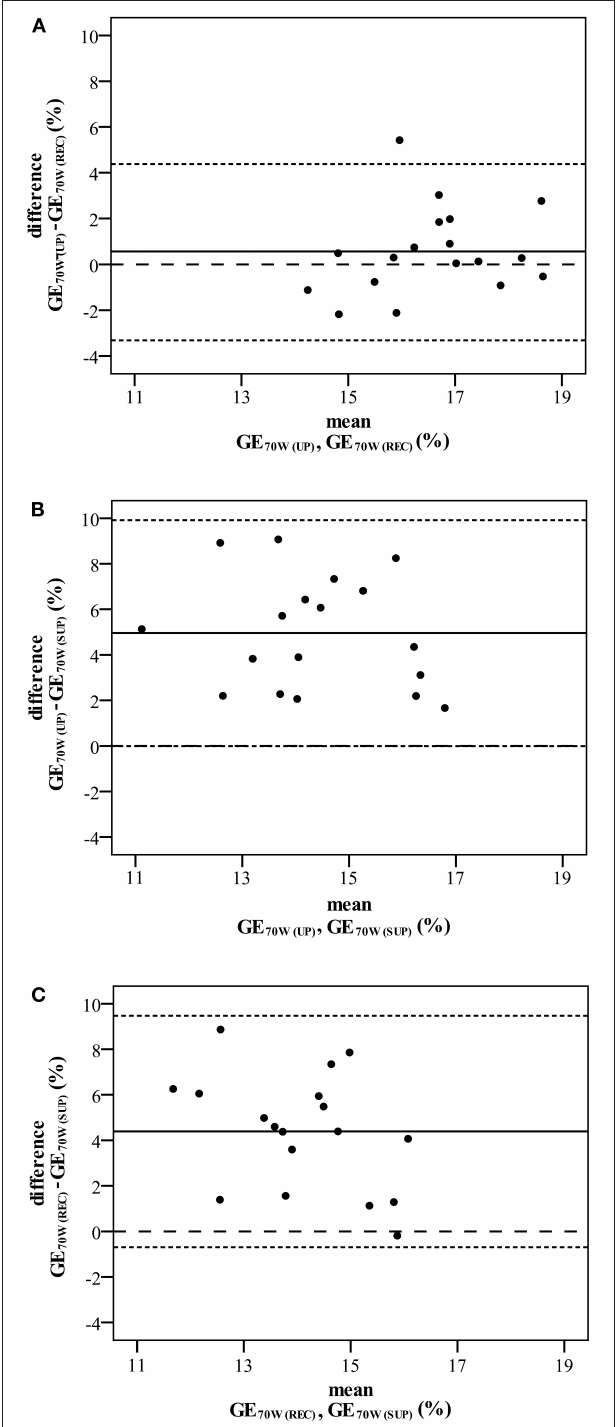
FIGURE 3 | Bland Altman plots comparing gross efficiency at 70 Watt (GE 70W ) during upright and recumbent cycling (A) , upright and supine cycling (B), and recumbent and supine cycling (C) . The middle solid horizontal lines correspond to the mean difference between postures, the upper and lower dotted horizontal lines represent the 95% limits of agreement given by the mean difference ± 2 SD . Dashed lines signify zero differences between